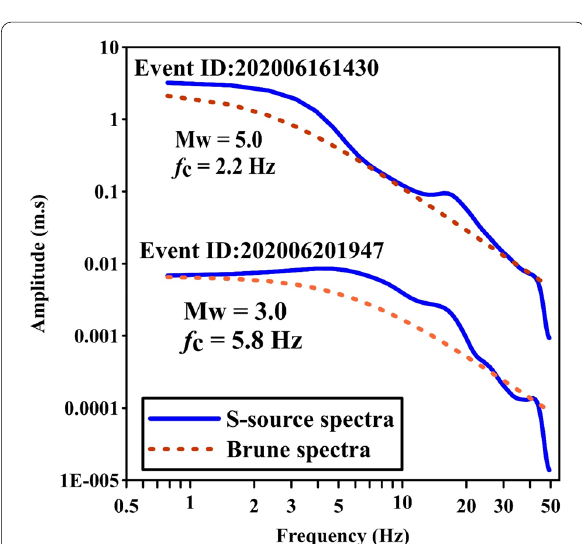
Fig. 8 A The average inverted spectra of the 16 Jun, 2020 main shock and its fitting with the theoretical model of Brune. B An example of the inverted spectra of the 20 Jun, 2020 aftershock event and its fitting with the theoretical Brune